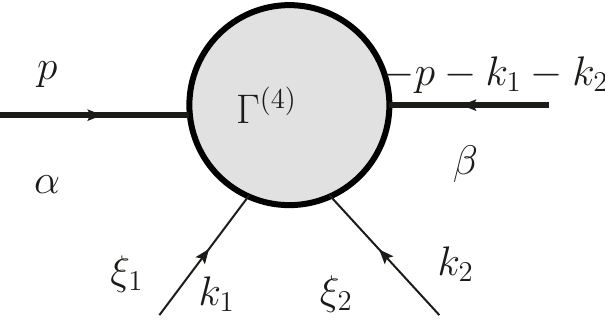
Figure 2 . 1PI vertex involving two (cid:12)nite energy particles and two soft particles.